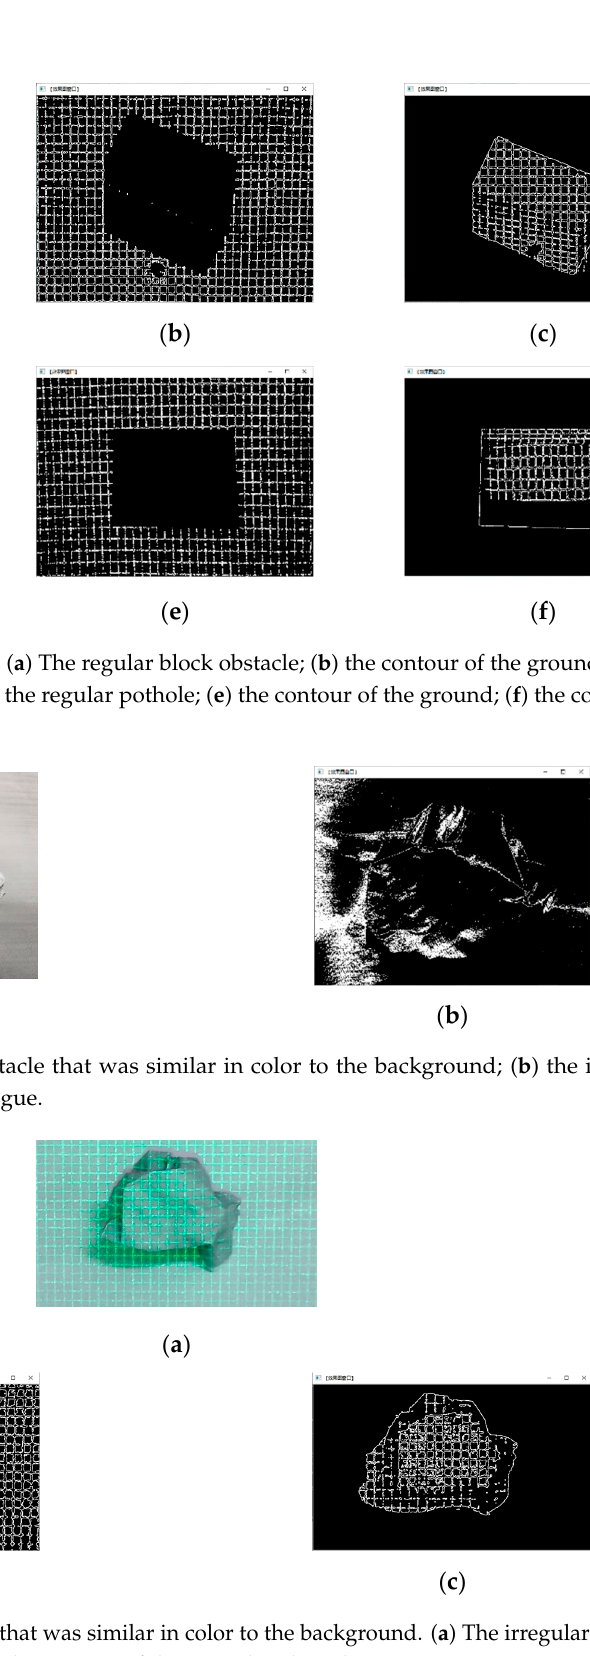
Figure 25. The irregular obstacle that was similar in color to the background. ( a ) The irregular obstacle ( b ) the contour of the ground; ( c ) the contour of the irregular obstacle.